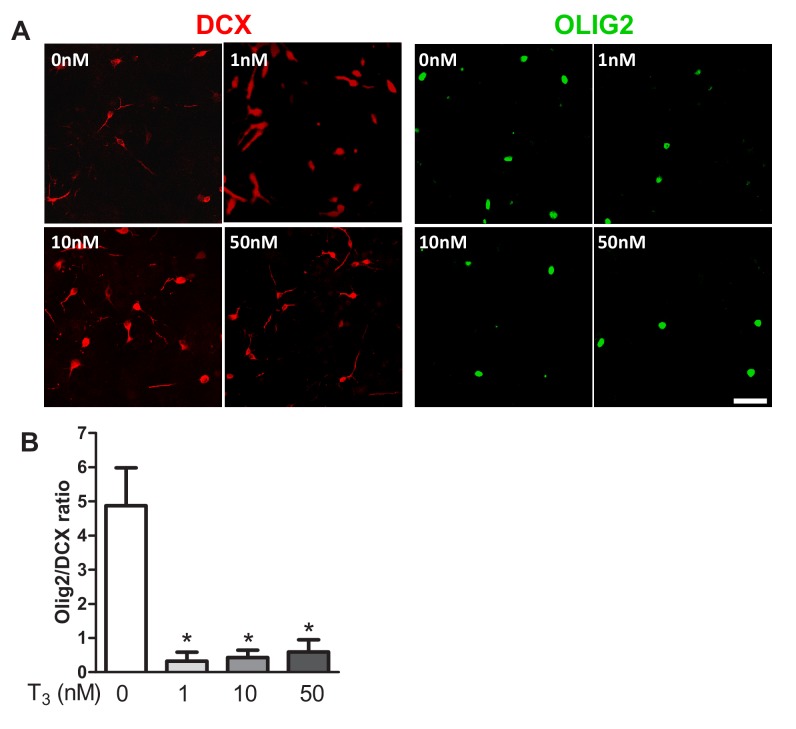
(A and B) SVZ tissues were sampled from WT adult mice for neurosphere culture.After plating, dissociated cells from neurospheres were induced to differentiate in presence of a short pulse of T3 at four different concentrations (0, 1, 10 and 50 nM). One week after initial plating, cells were fixed and stained with antibodies against DCX (red) and OLIG2 (green). (A) Representative distributions of DCX+ and OLIG2+ cells are shown for each T3 dose. Scale bar: 50 µm (B) Quantification of the DCX/OLIG2 ratio is shown for each dose of T3. The ratio decreased in a dose-dependent manner. (mean ± SEM, n = 4 per group. *p<0.05, Kruskal-Wallis Test).